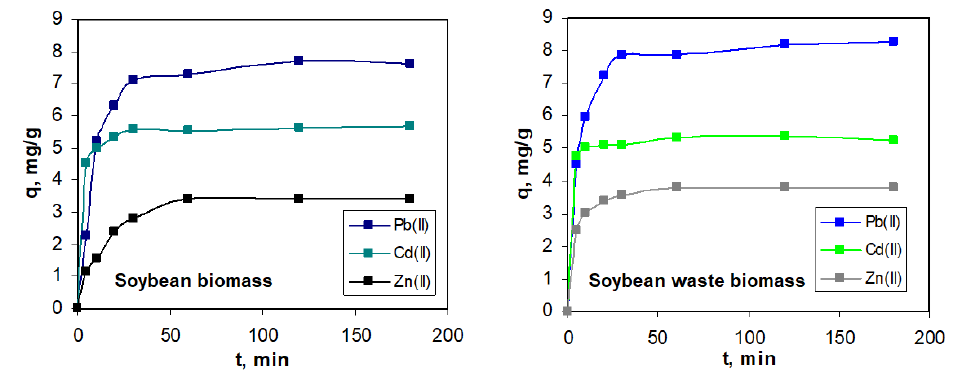
Figure 7. Influence of contact time on sorption capacity of Pb(II), Cd(II), and Zn(II) ions in aqueous solutions by soybean biomass and soybean waste (pH = 3.39; DS = 5 g/L; c 0 = 83.29 mg Pb(II)/L; 46.11 mg Cd (II)/L; 52.31 mg Zn(II)/L; temperature T = 24 °C).